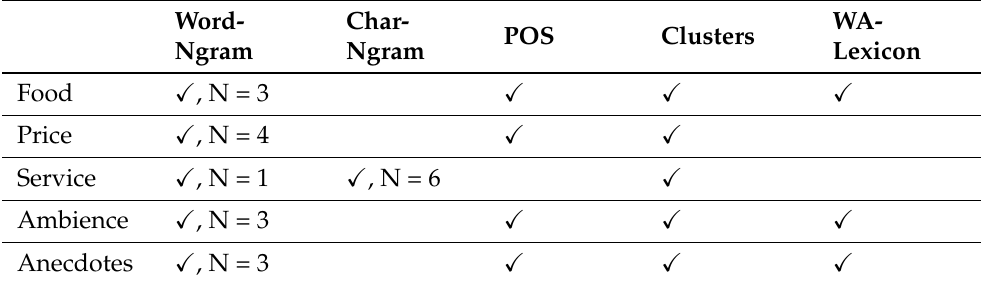
Table 3. The features used to detect each aspect